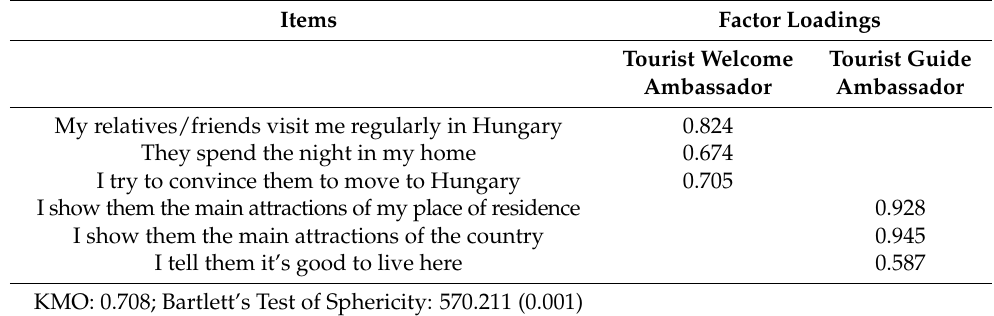
Table 3. The Chinese hosts’ role in VFR travel as ‘tourist welcome and tourist guide ambassadors’. Items Factor Loadings Tourist Welcome